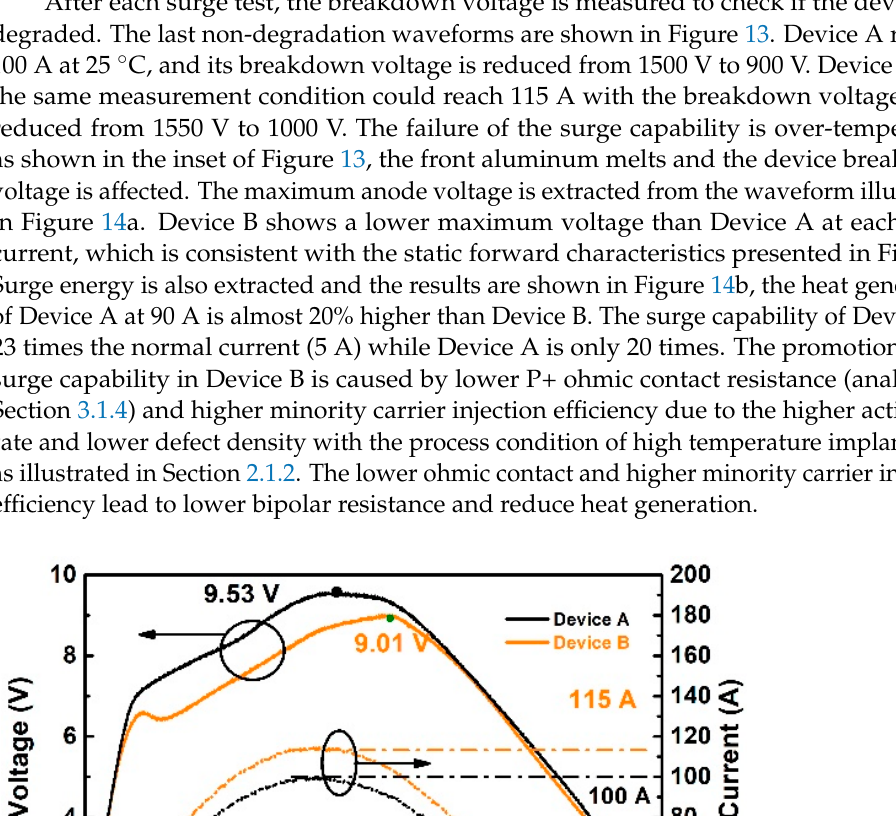
Figure 12. ( a ) Surge voltage waveforms of device B with the increased surge current. ( b ) Surge voltage waveforms of device B with the increased surge current. ( c ) Surge waveforms (30–60 A) of device B are replotted in the IV curve. ( d ) Surge waveforms (>60 A) of device B are replotted in the